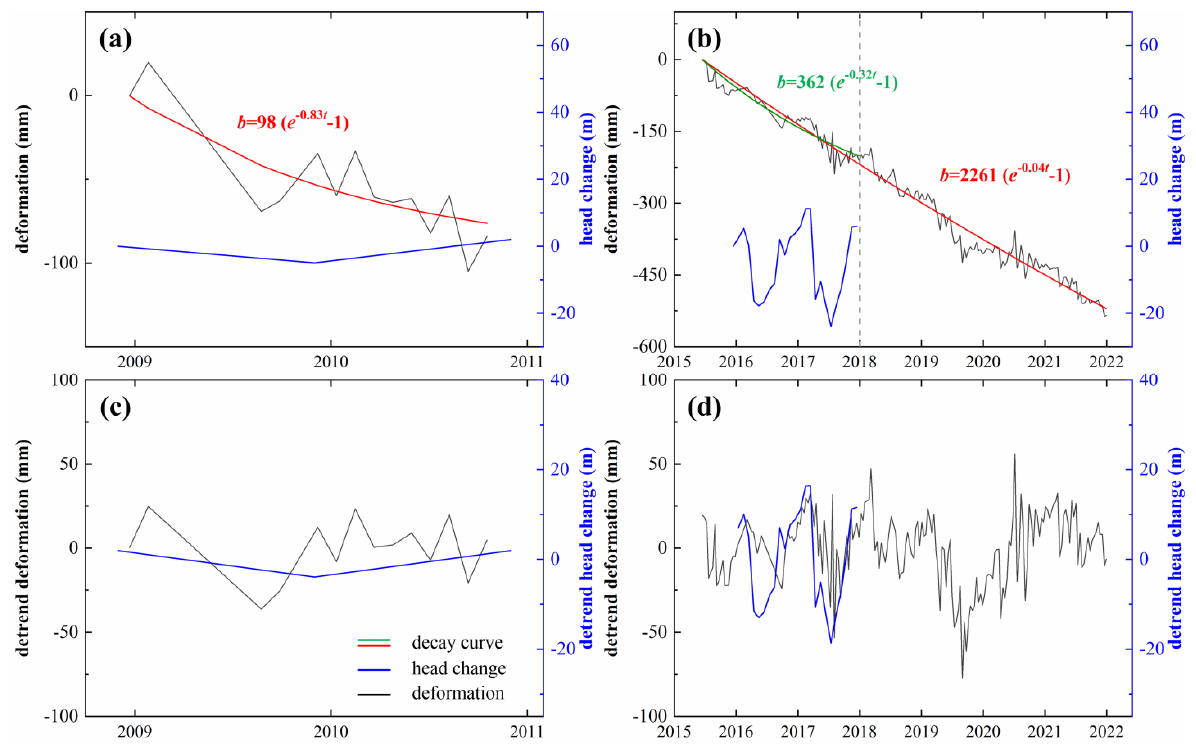
Figure 4. Comparison between mean displacement time series (gray line) for pixels within a 500 m radius around well D117 and head changes (blue line) during ( a ) 2009–2010 and ( b ) 2015–2021. Comparison between de-trended deformation (gray line) and de-trended head changes (blue line) during ( c ) 2009–2010 and ( d ) 2015–2021. The red and green lines represent the decay curve estimated by using the exponential decay model of time.